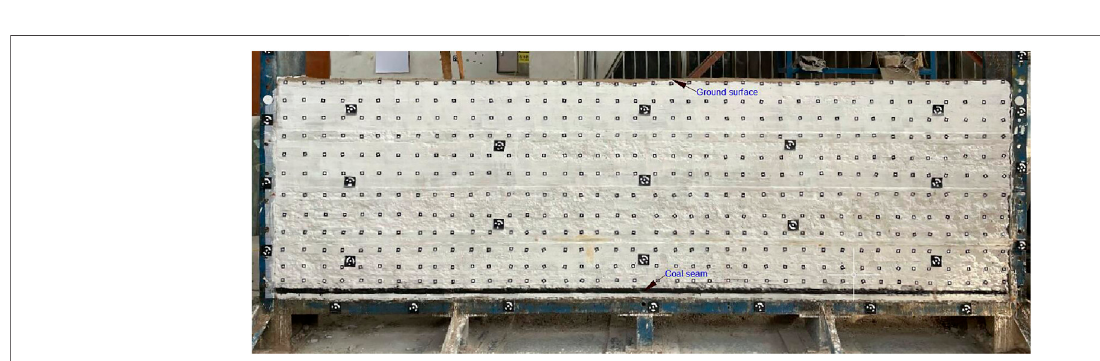
FIGURE 6 | Physical model